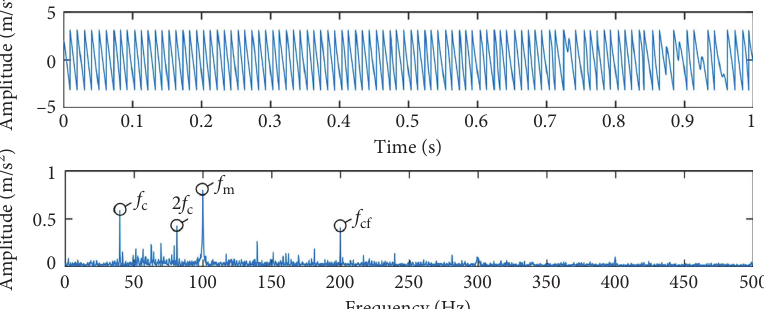
Figure 16: Signal processed by